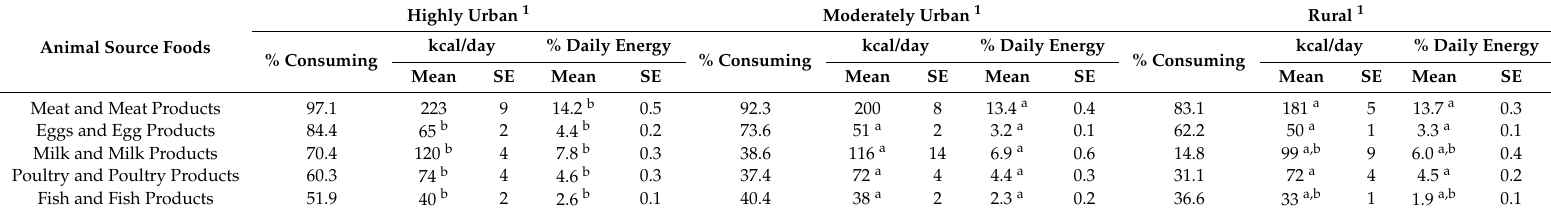
Table 4. Energy contribution from different animal source foods among consumers and by community type,